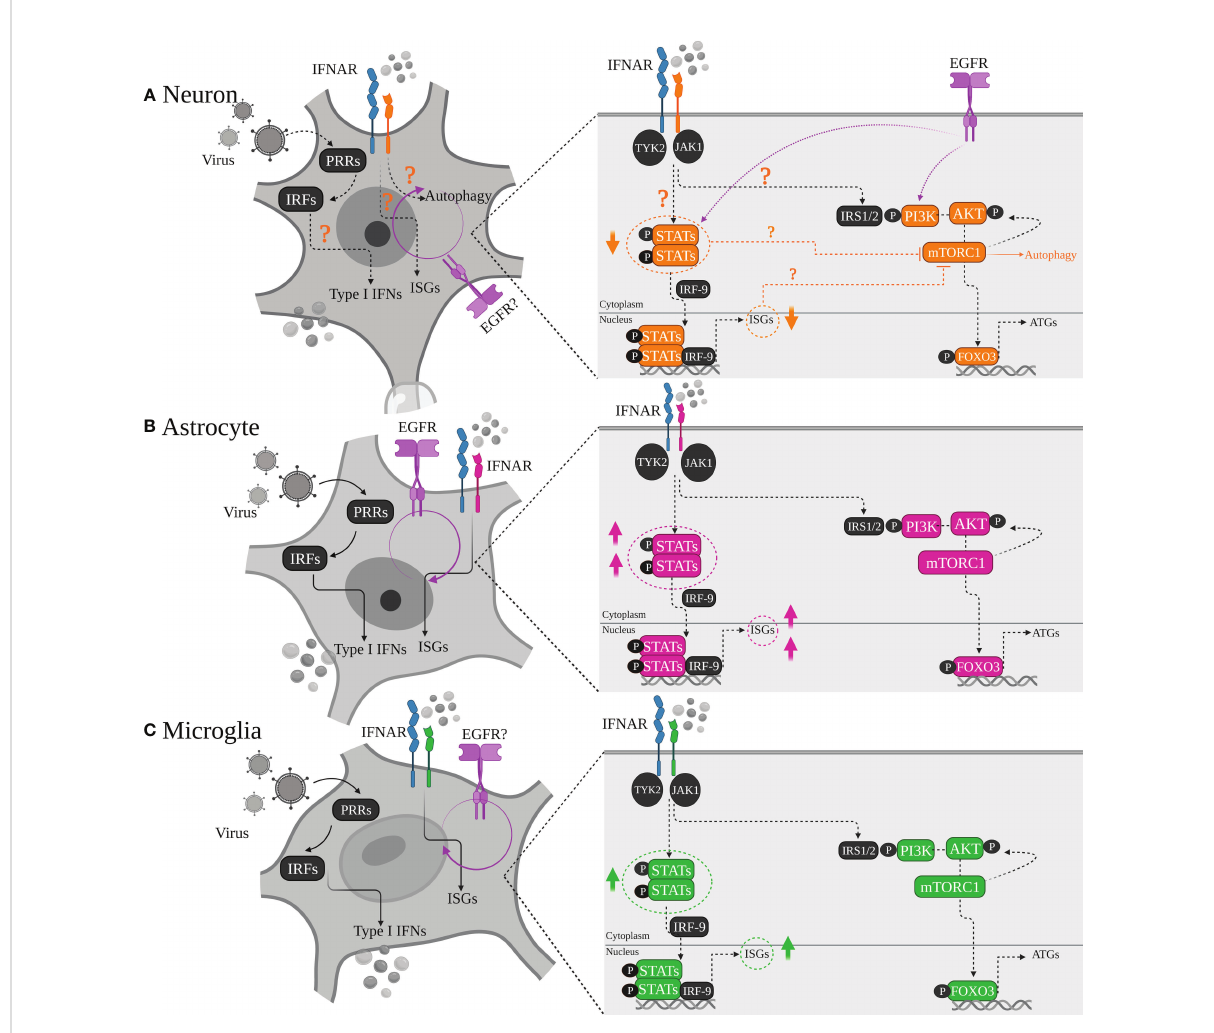
FIGURE 2 Differential type I IFN/IFNAR responses of major brain cell types. (A) Neurons, (B) Astrocytes and (C) Microglia are all equipped with machinery for viral sensing and can mount an antiviral response, particularly by inducing type I IFN production through various signaling pathways which intersect at activation of different protein kinases and IRF transcription factors, leading to induction of IFN gene transcription downstream. Although all tree cell types produce type I IFN, with astrocytes being major IFN- b producers, and microglia as the main source of IFN- a , there is a heterogenicity regarding neurons IFN responsiveness. Some neurons prefer autophagy rather than ISGs upregulation and induction of a typical antiviral state. This has been linked to lower STATs or basal ISGs levels in neurons compared to other cell types depending on cells developmental state, regional diversity, neuronal sub-types which may play de fi nitive roles in shaping the outcome of the viral